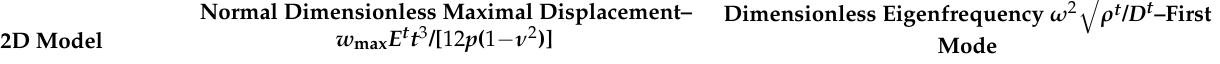
Table 2. Comparison of analytical and FE results for different 2D models of triangular clamped isotropic plates (t/L = 0.1, D t / p = 1, ρ t / D t =